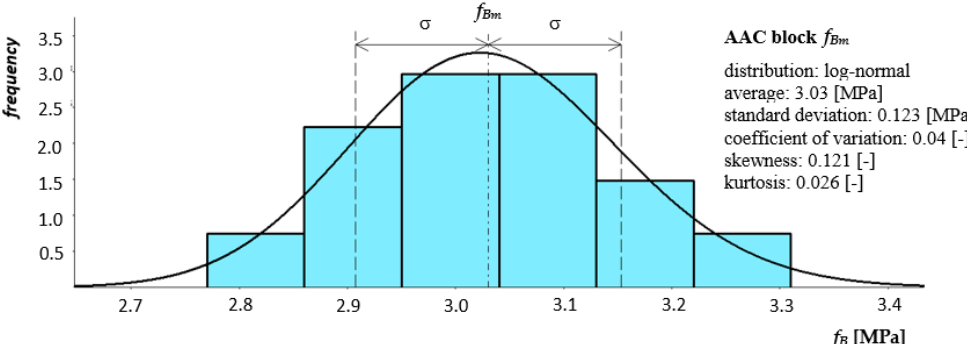
Figure 15. Histogram together with the approximate function of the compression strength distribution of autoclaved aerated concrete block.